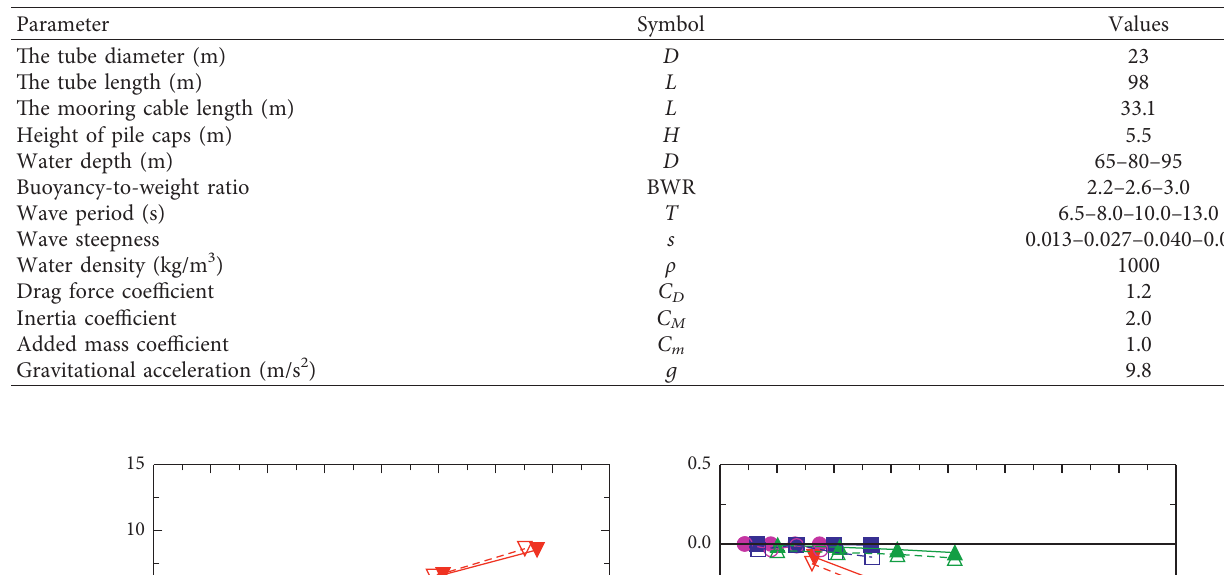
Table 2: Basic parameters of the numerical example.